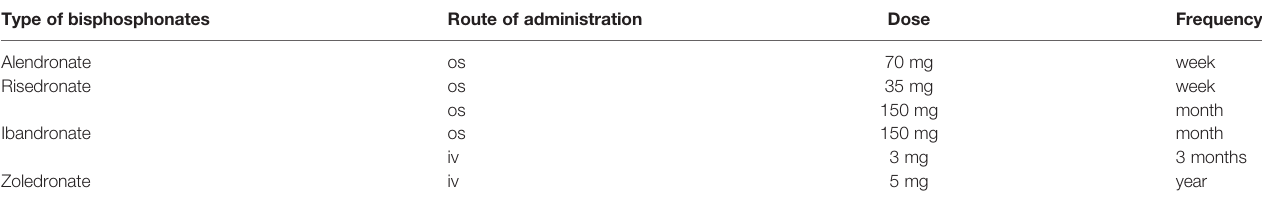
TABLE 4 | Recommended dosages of orally and intravenously bisphosphonates in bariatric surgery patients affected by